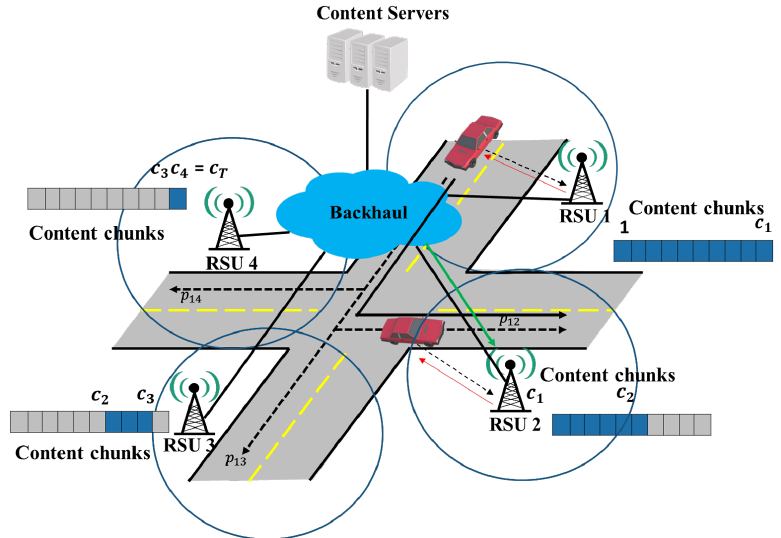
Figure 4. The proposed caching strategy for a vehicle and each